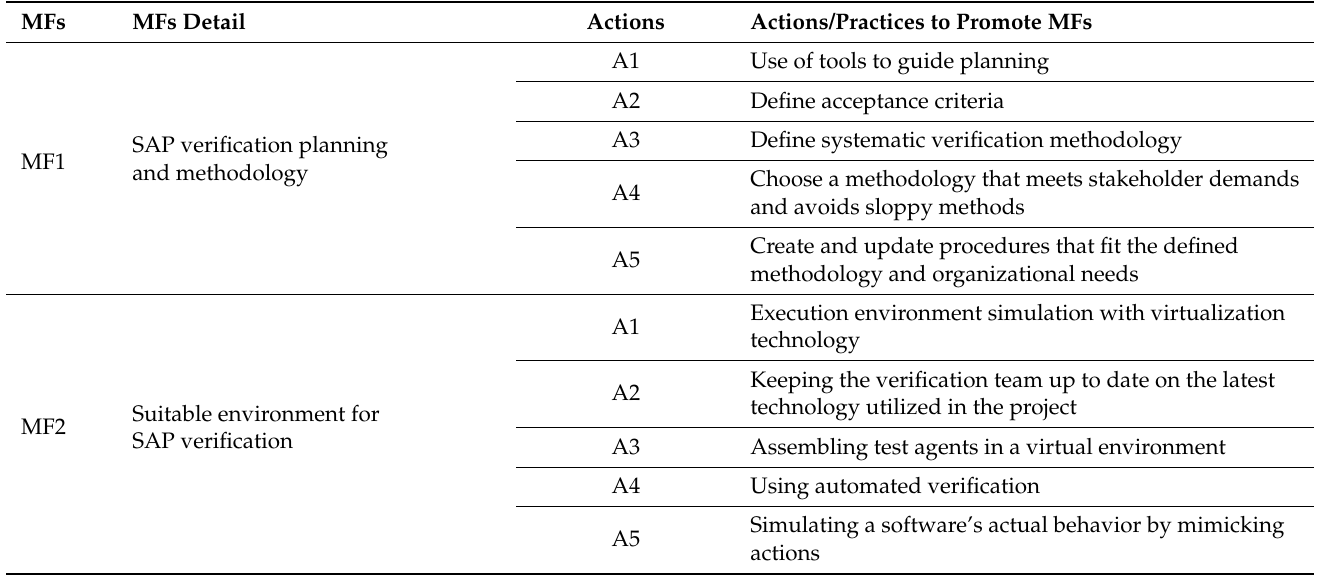
Table 3. MFs and the corresponding actions to promote these